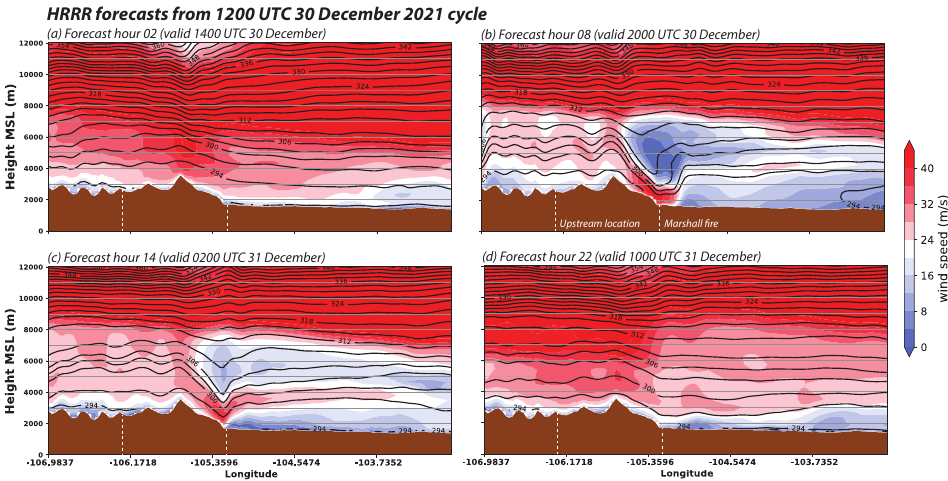
Figure 5. Vertical cross-sections of wind speed (shaded, m/s) and potential temperature (3 K con- tours), oriented west–east across the Marshall fire ignition site as indicated on Figure 1, from the HRRR model run started 1200 UTC 30 December 2021. Forecasts shown are for ( a ) hour 2 (1400 UTC 30 December), ( b ) hour 8 (2000 UTC 30 December), ( c ) hour 14 (0200 UTC 31 December), and ( d ) hour 22 (1000 UTC 31 December). Approximate locations for Marshall fire and upstream locations indicated (vertical white dashed lines).